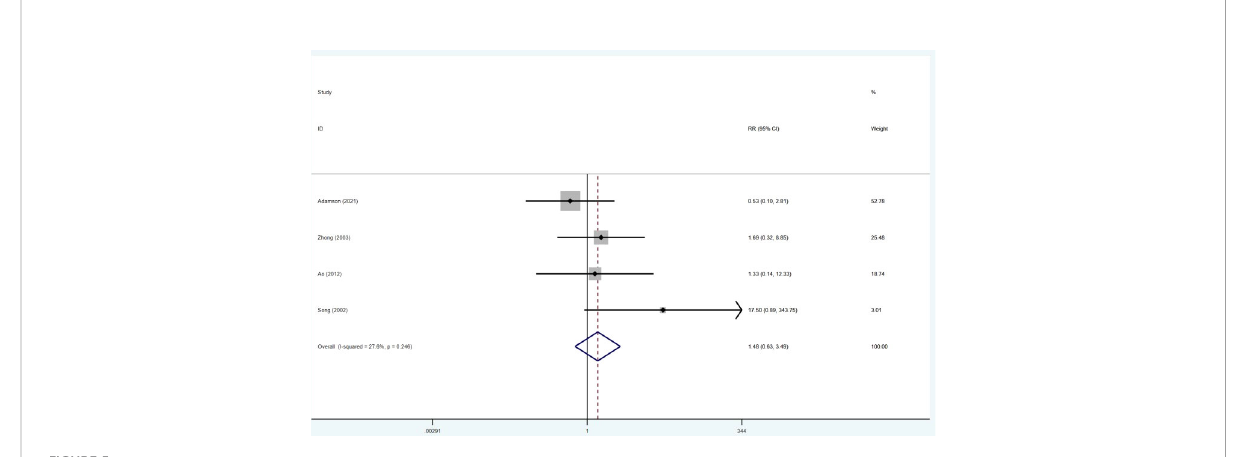
FIGURE 5 Forest plot for the results of bleeding